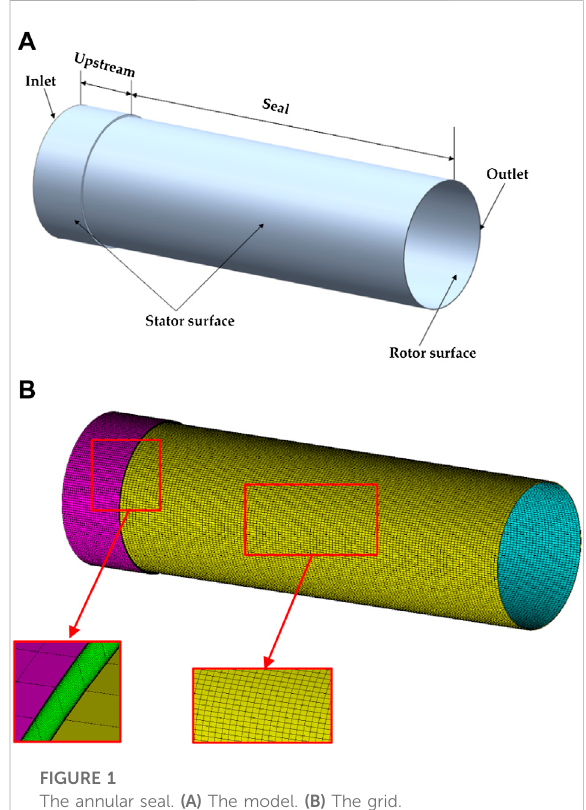
FIGURE 1 The annular seal. (A) The model. (B) The grid.